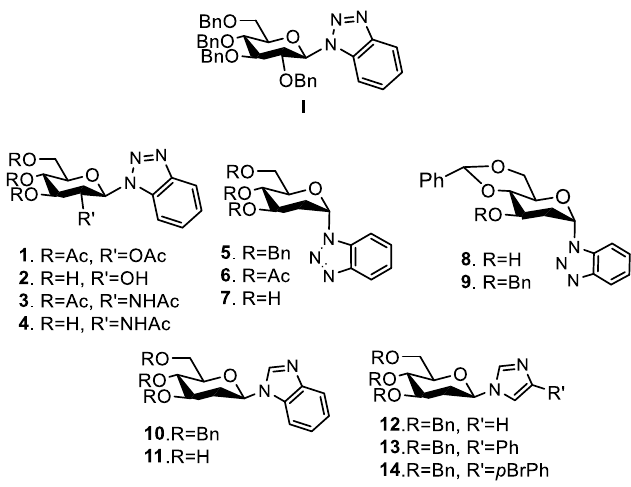
Figure 1. Targeted Figure 1. Targeted compounds.